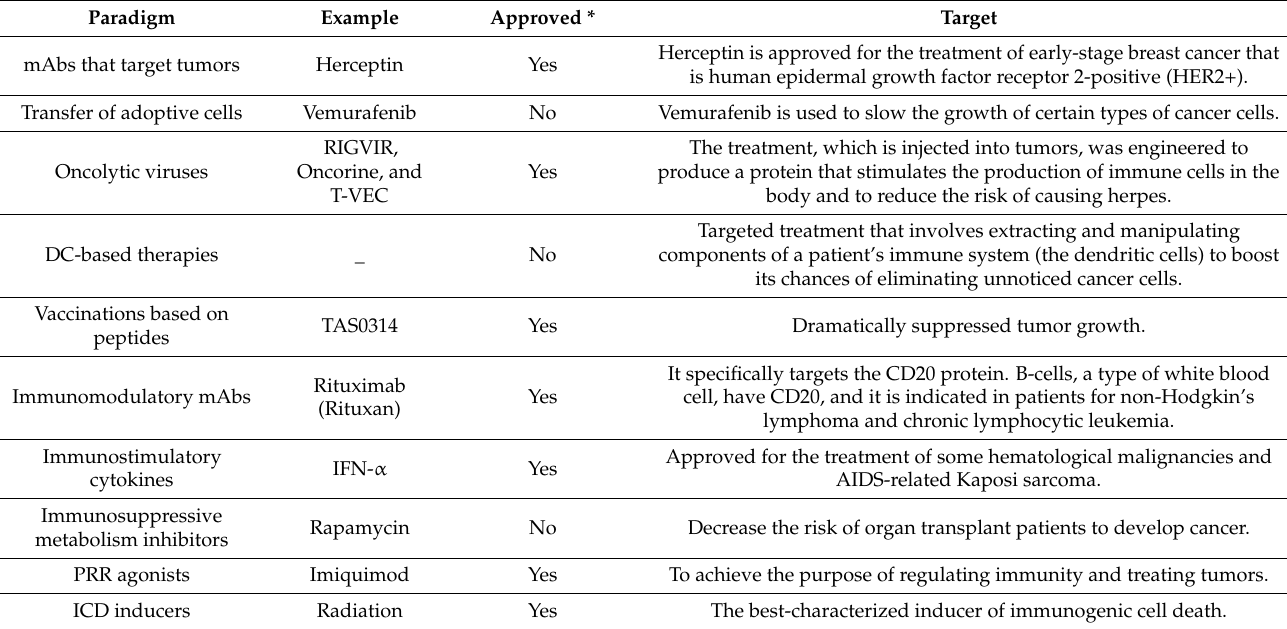
Table 3. Immunotherapies for cancer currently on the market